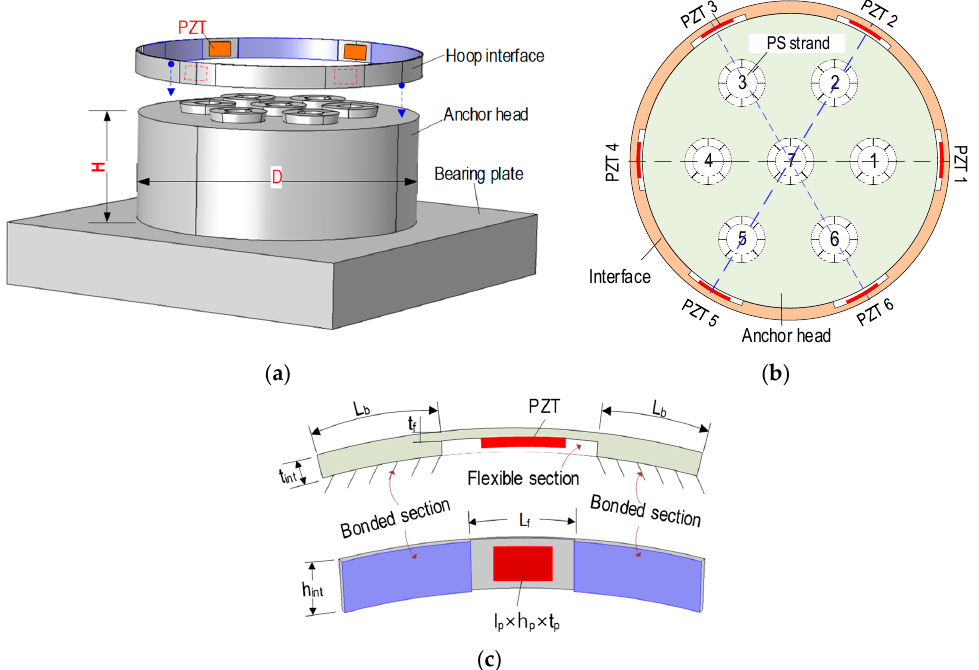
Figure 6. Design of a hoop-type PZTs interface for multi-strand anchorage system. ( a ) Hoop-type PZT interface on a multi-strand anchorage system, ( b ) multi-PZTs interface, and ( c ) segmental PZT interface.